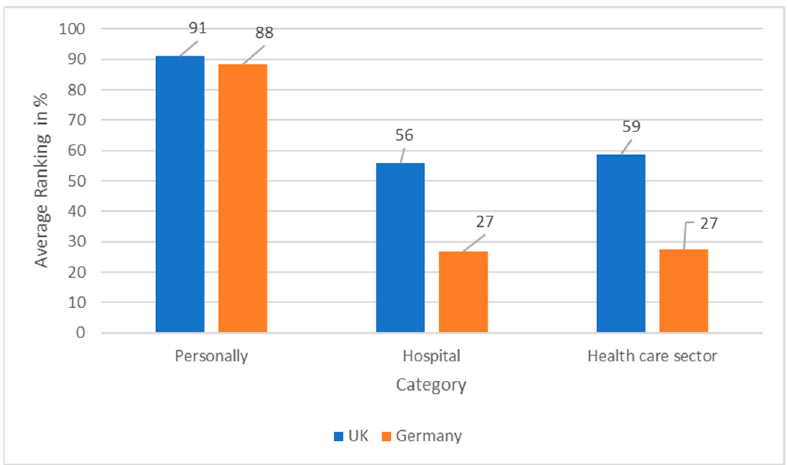
Figure 1. Bar graph illustrating the ranking of importance for sustainability from personal to health sector level.